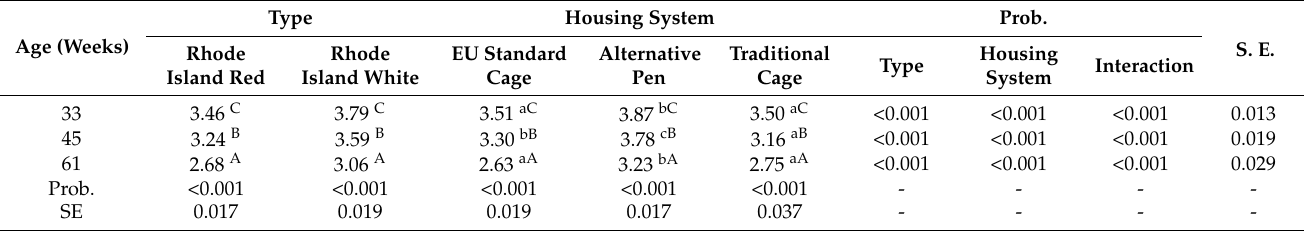
Table 3. Effect of type and housing system on the plumage points on the neck feathers of non-beak- trimmed Rhode Island